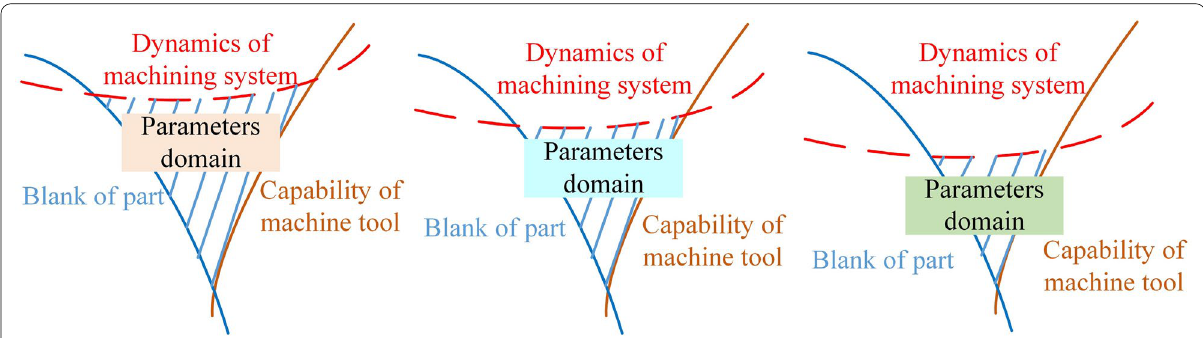
Figure 2 Varying domain of appropriate parameters in whole cutting process